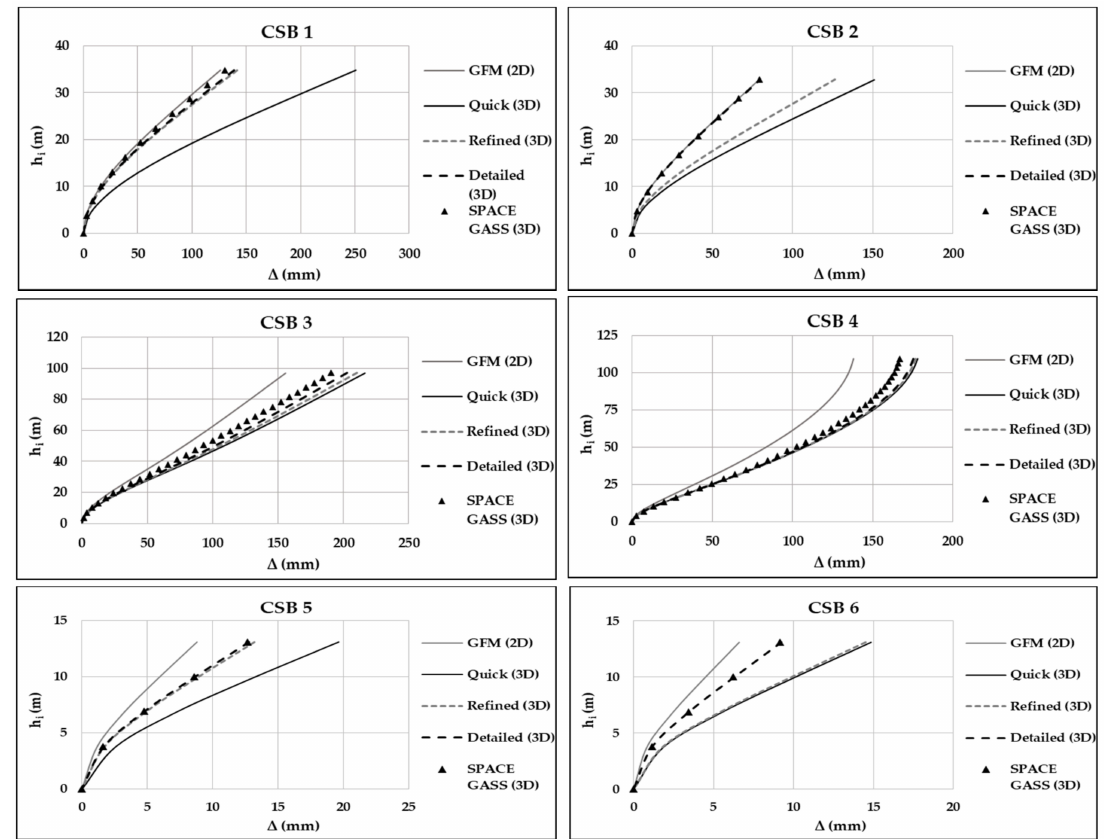
Figure 18. Comparison of the displacement profile of the 3D displacement of the case study buildings estimated by the developed method and results from SPACE GASS. The Generalised Force Method (GFM) (2D) displacement profile is obtained using the Generalised Force Method of analysis and is presented as a lower bound estimate. The method has been presented in an earlier study by the authors